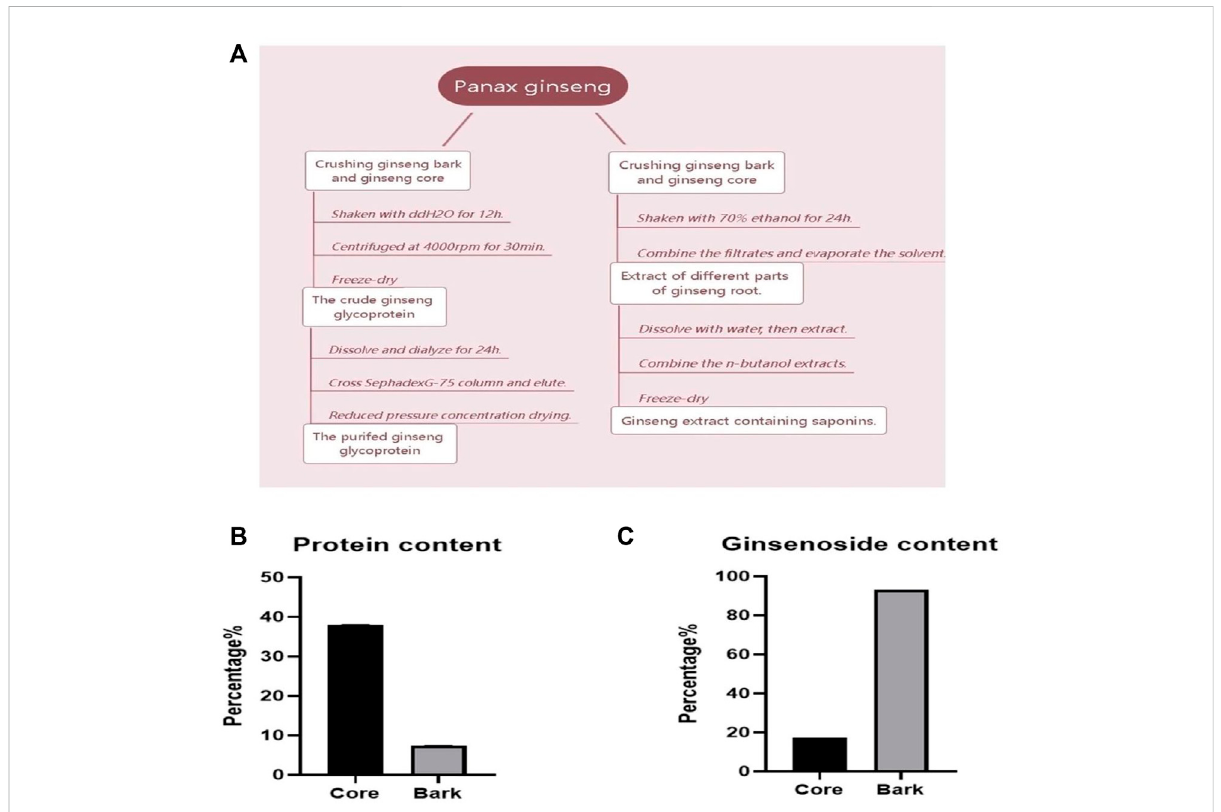
FIGURE 1 Determination of saponin and glycoprotein content in different parts of ginseng roots. (A) Flow chart of ginsenoside and ginseng glycoprotein extraction from different parts; (B) Percentage of saponins content in different parts of ginseng roots; (C) Percentage of glycoprotein content in different parts of ginseng roots.